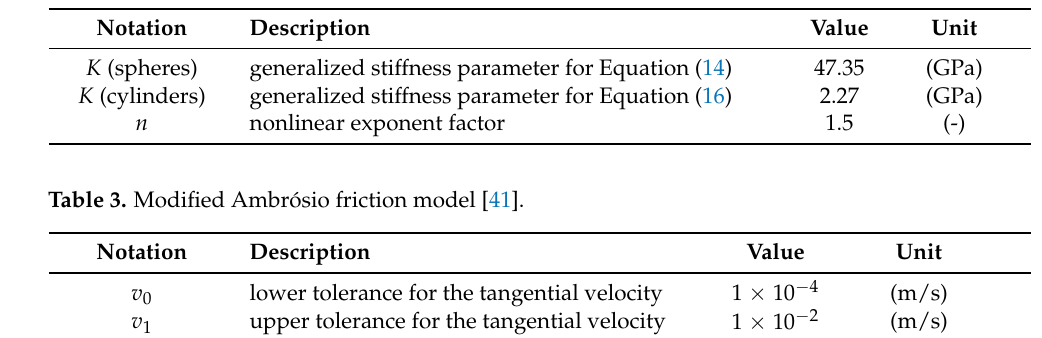
Table 2. Lankarani-Nikravesh impact model [20].